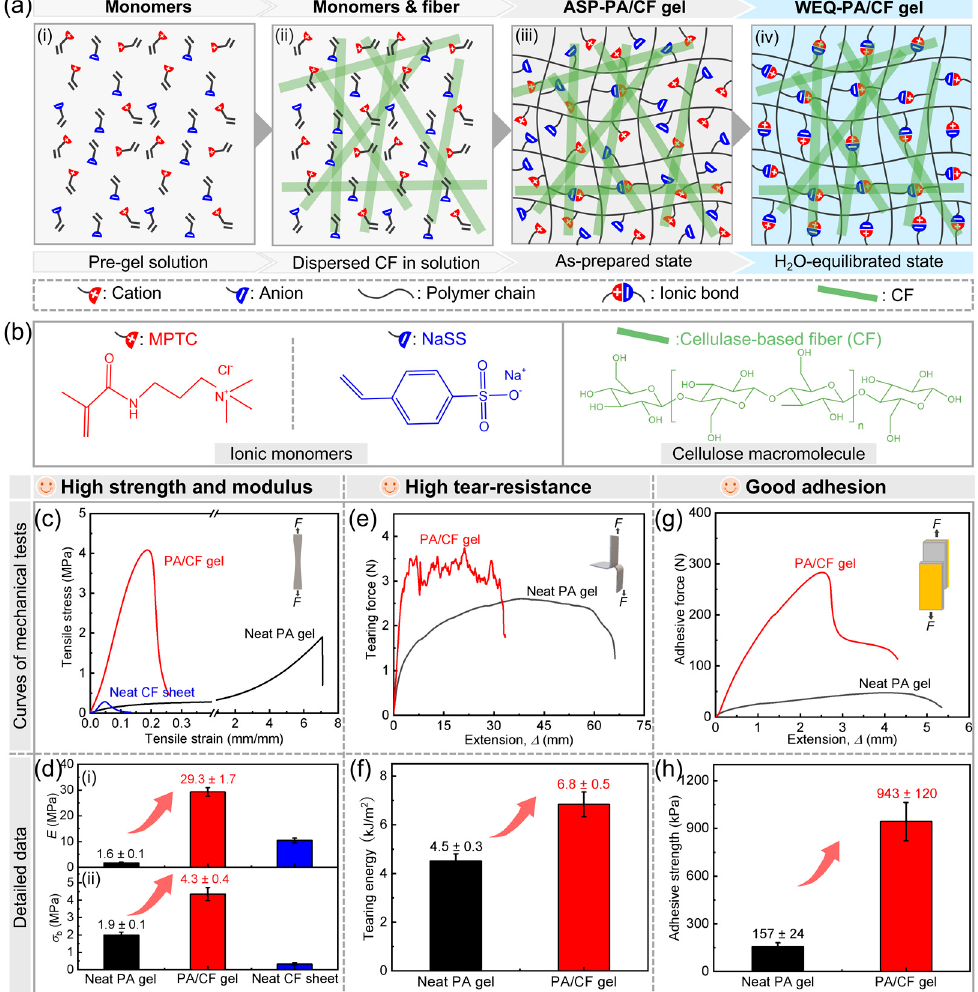
Figure 1. Design, fabrication, and proof of strong, tough, and adhesive PA/CF composite hydrogels. ( a ) Design of the proposed approach. “ASP” and “WEQ” represent “as-prepared” and “water-equilibrated”, respectively. The corresponding counter-ions are not shown in the schemes. ( b ) Chemical structures of the monomers and cellulose macromolecule. ( c – h ) Results of mechanical tests demonstrate dramatically enhanced mechanical properties: ( c ) tensile stress-strain curves and ( d ) corresponding Young’s modulus ( E ) and tensile fracture strength ( σ b ), ( e ) tearing force-extension curves and ( f ) corresponding tearing energy, ( g ) adhesive force-extension curves based on lap-shear tests and ( h ) corresponding adhesive strength. ϕ CF = 6.0 wt%.